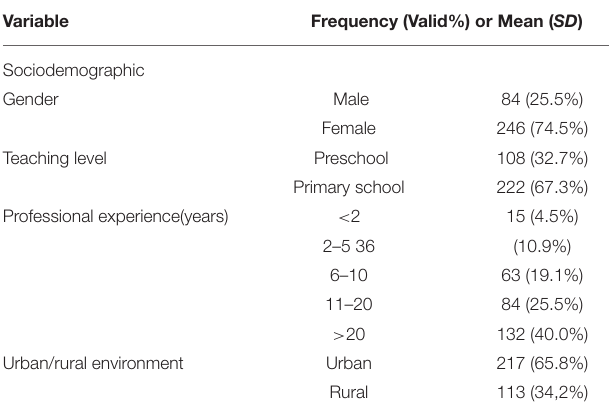
TABLE 1 | Descriptive statistics for sociodemographic variables.